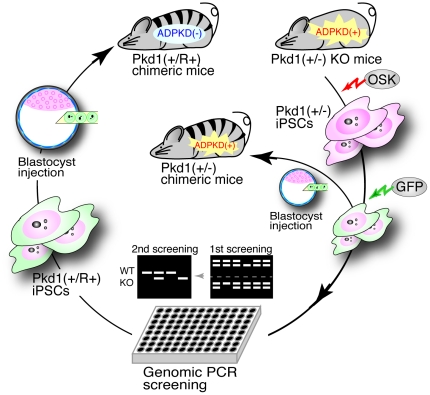
Scheme of in vitro screening and in vivo assay of mutation-restored Pkd1(+/R+) iPSCs.The knockout (KO) allele of Pkd1 is spontaneously replaced with the wild-type allele through mitotic recombination occurring in rounds of cell division of Pkd1(+/−) iPSCs. Phenotype of ADPKD (autosomal dominant polycystic kidney disease) caused by the mutation of Pkd1 is detected in kidneys from adult chimeric mice with Pkd1(+/−), but not Pkd1(+/R+), iPSCs.